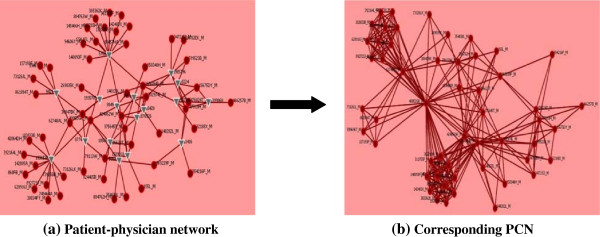
Construction of PCN from research dataset. The red circle represents physician and the gray triangle represents patient.